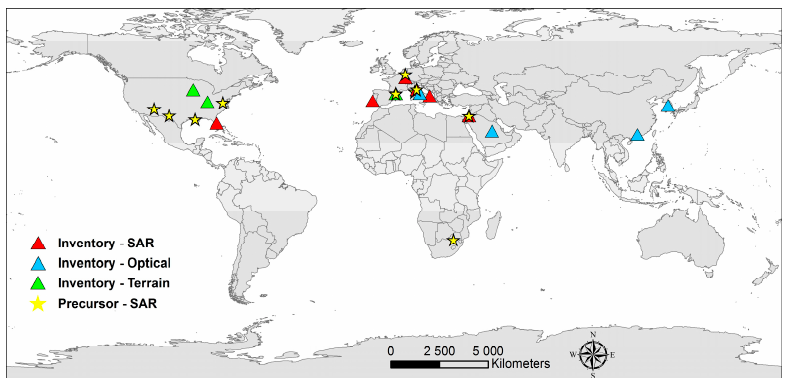
Figure 4. Earth observation techniques have been used worldwide for sinkhole precursor detection (stars) and sinkhole inventory compilation using optical remote sensing (blue triangles), remotely generated terrain models (green triangles) and DInSAR techniques (red triangles).